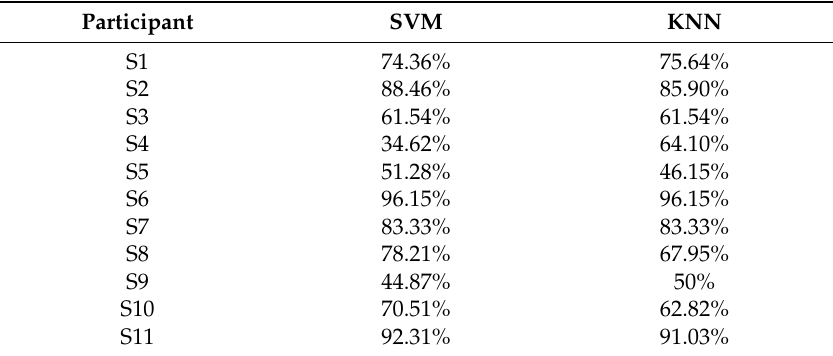
Table 9. Accuracy performance of each system to each